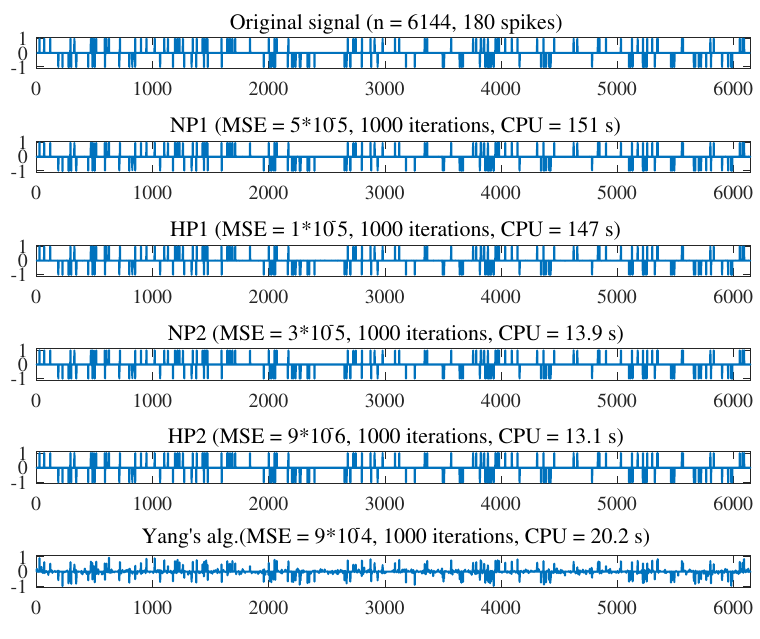
Figure 2. Comparison of signal